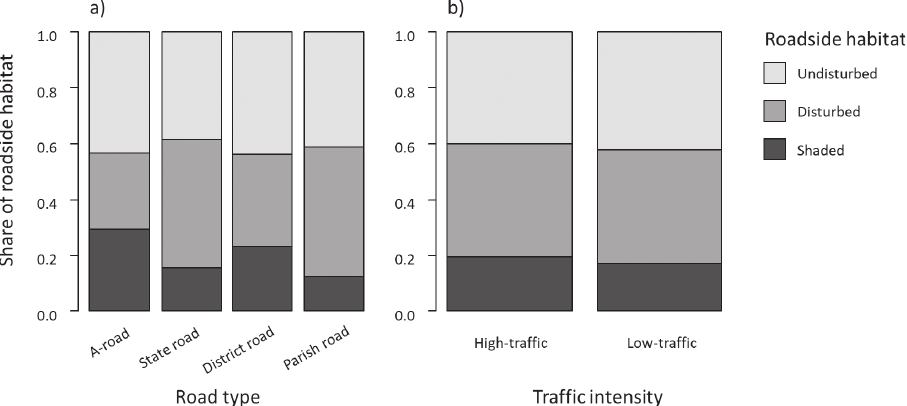
Figure A111. Distribution of roadside habitat types within a road types b categories of traffic intensity over the entire road